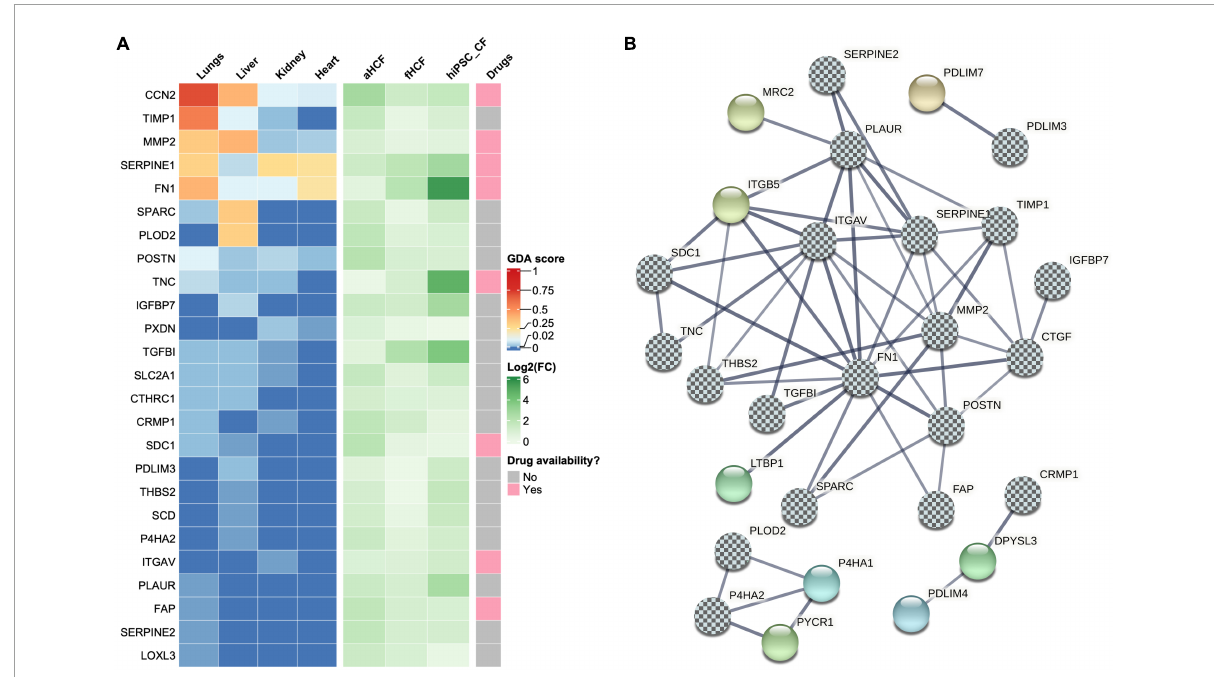
FIGURE5 Identification of potential therapeutic targets in cardiac fibrosis (A) Heatmaps show upregulated DEPs associated with fibrotic conditions. In left panel each column represents a gene-disease association score (GDA score) attributed by DisGeNET. Center panel shows the log2 (fold-change) for each CF source. Right panel shows drug availability for direct targeting of those proteins. (B) Co-expression network of upregulated proteins associated with fibrotic conditions. The chess pattern highlights fibrosis-associated